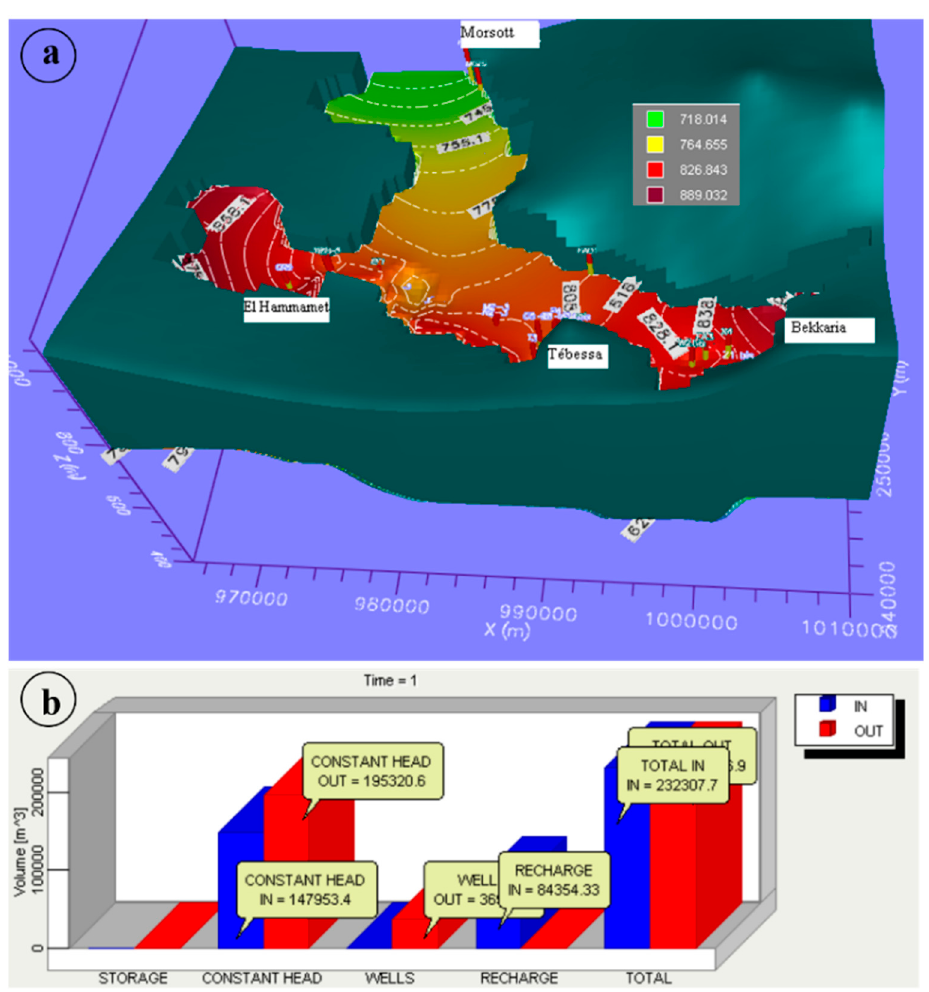
Figure 5. ( a ) Groundwater flow map for steady-state simulation. ( b ) Water budgets for steady-state simulation (May 2010).